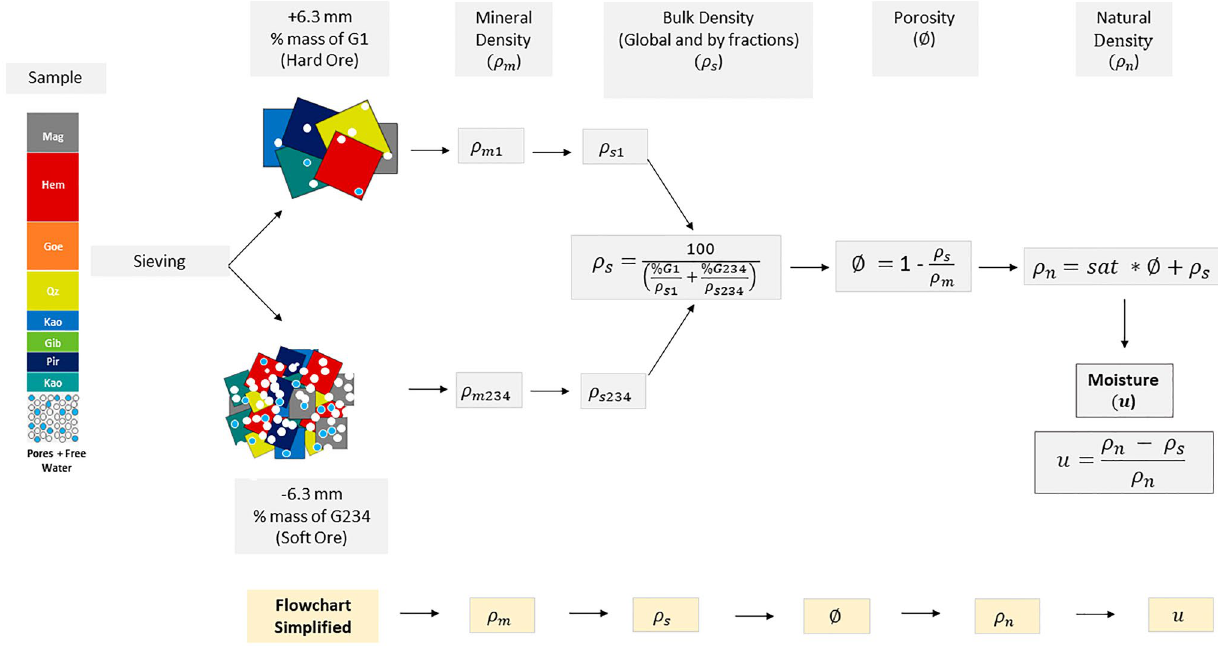
Fig. 6 Flowchart of the moisture estimate method using